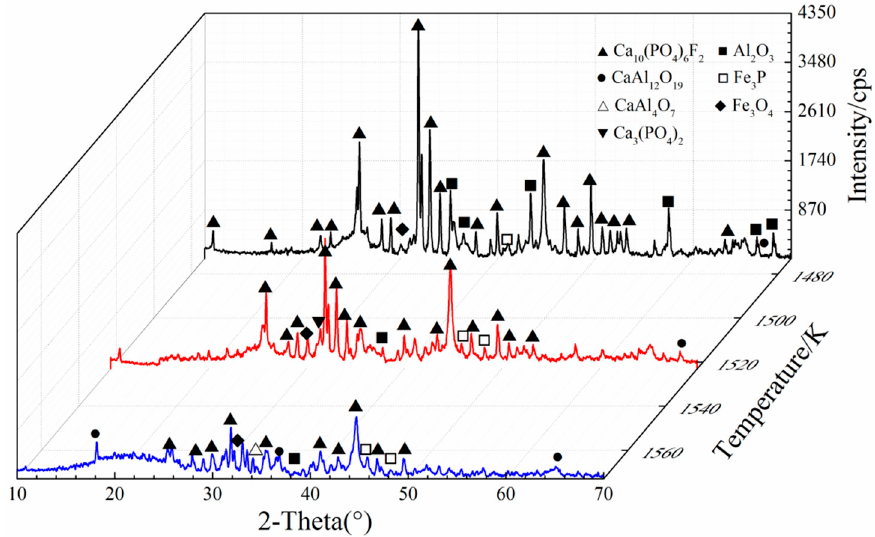
Figure 9. XRD pattern of the product of reduction at different temperature in the Ca 10 (PO 4 ) 6 F 2 –Al 2 O 3 – Fe 2 O 3 –C